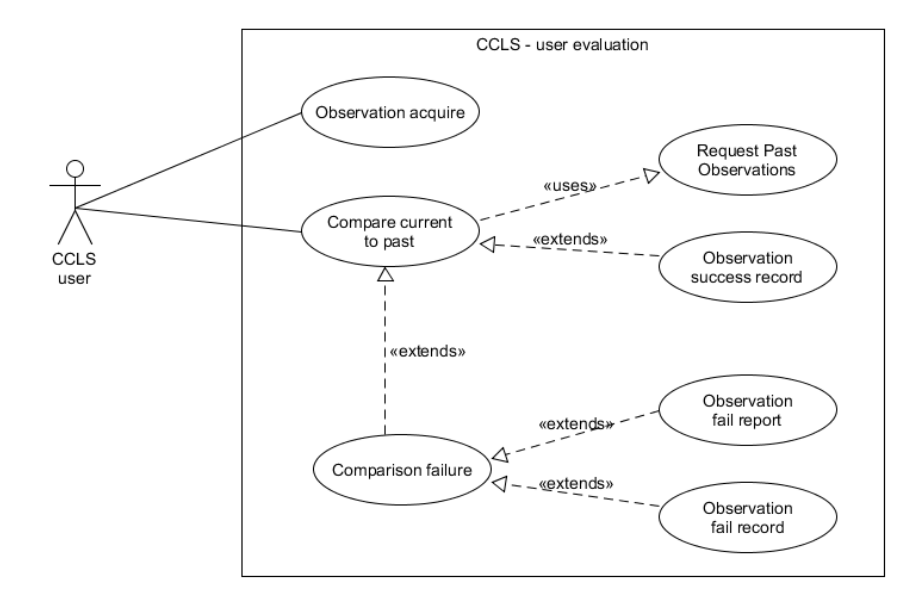
Figure 12: CCLS user evaluation use case UML